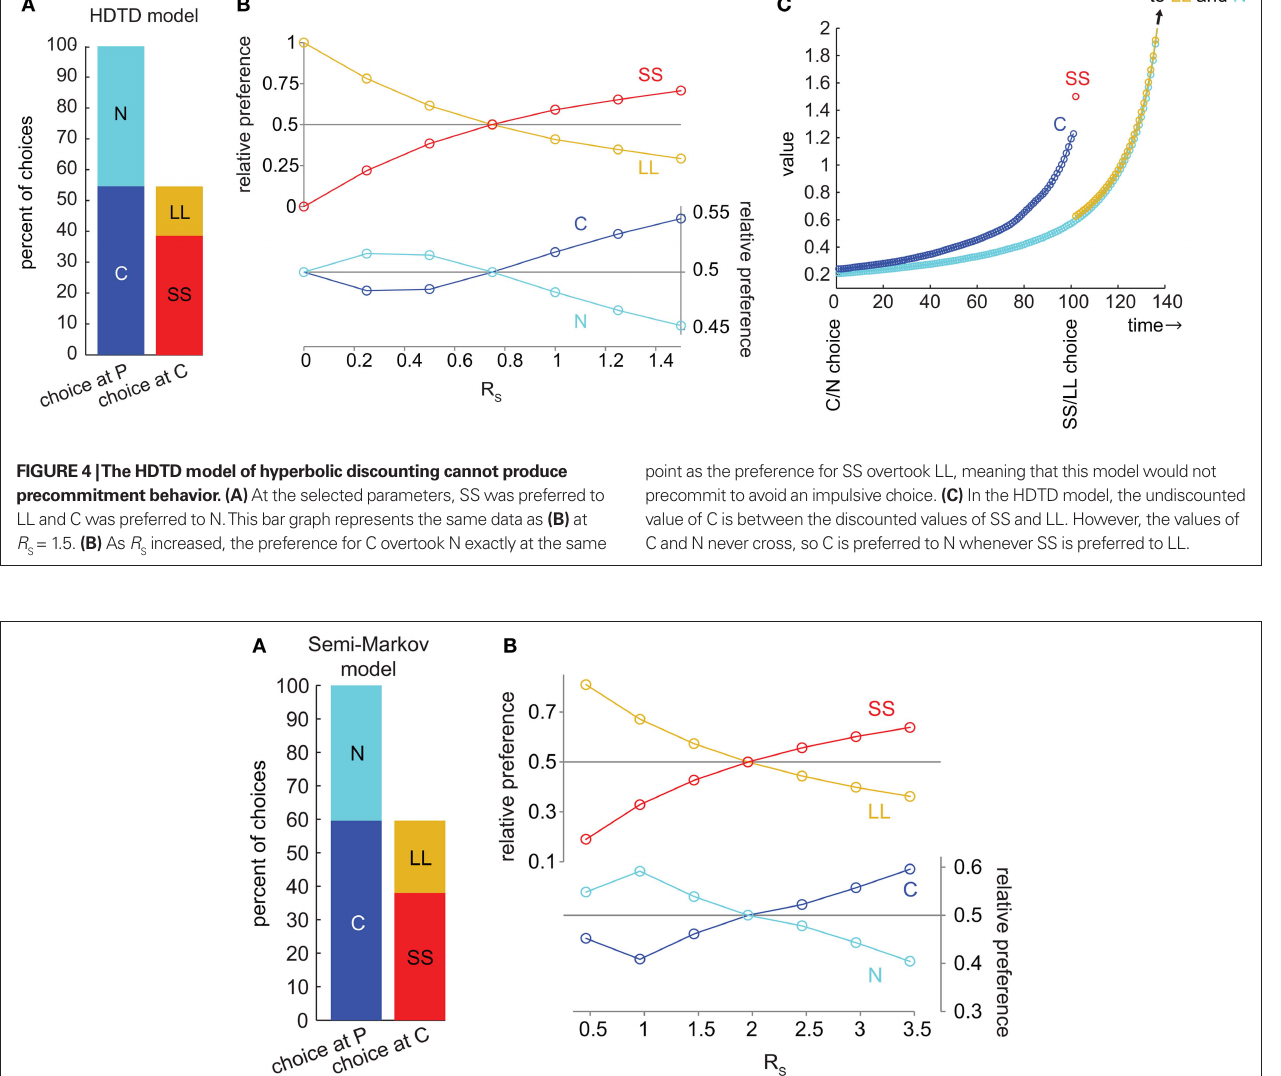
overtook LL, meaning that this model would not precommit to avoid an Figure 5 | The semi-markov model of hyperbolic discounting (without impulsive choice. Note that in this model, each state has a long temporal extent distributed discounting) cannot produce precommitment behavior. (A) At (and replacing long states with one-step states produces different discounting), the selected parameters, SS was preferred to LL and C was preferred to N. This so it is not possible to plot intermediate discounted values as in bar graph represents the same data as (B) at R = 3.46. (B) As R increased, the S S Figures 2C, 3C, and 4C . preference for C overtook N exactly at the same point as the preference for SS